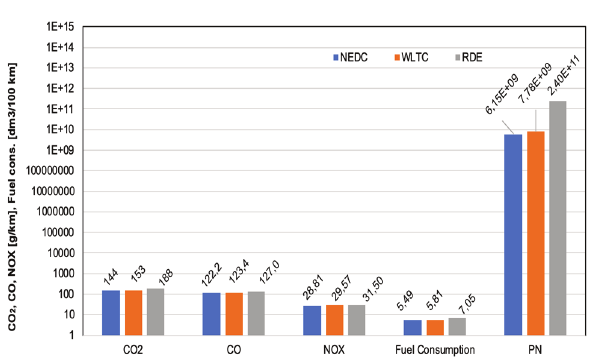
Fig. 15. Comparison of chosen results of road emissions and fuel con- sumption in the tested vehicle in respective driving